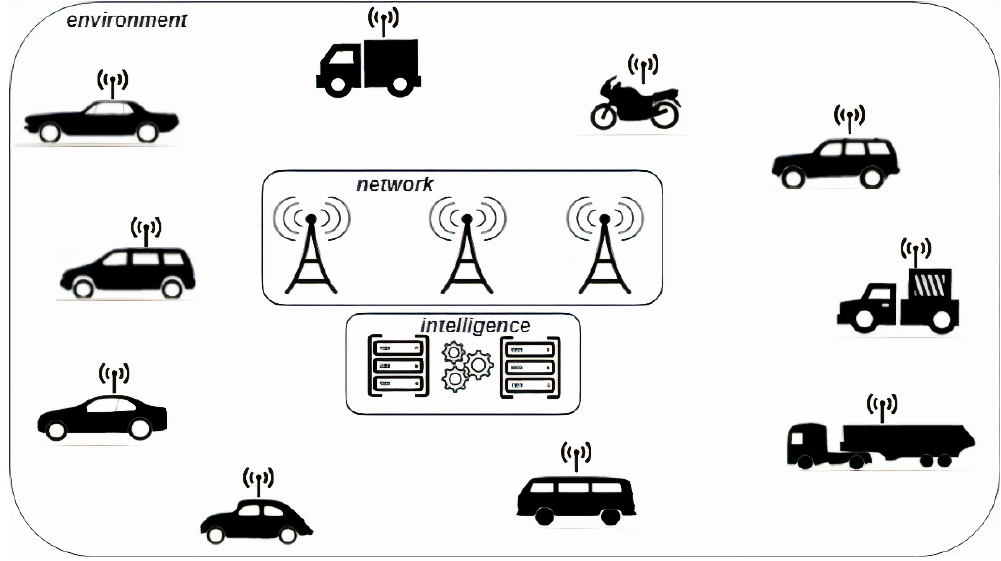
Figure 3. The high-level